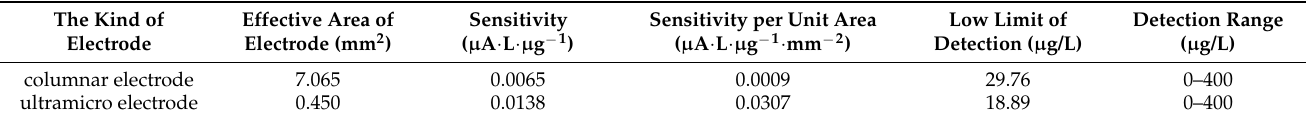
Table 2. Comparison of the detection sensitivity of different kinds of electrodes.